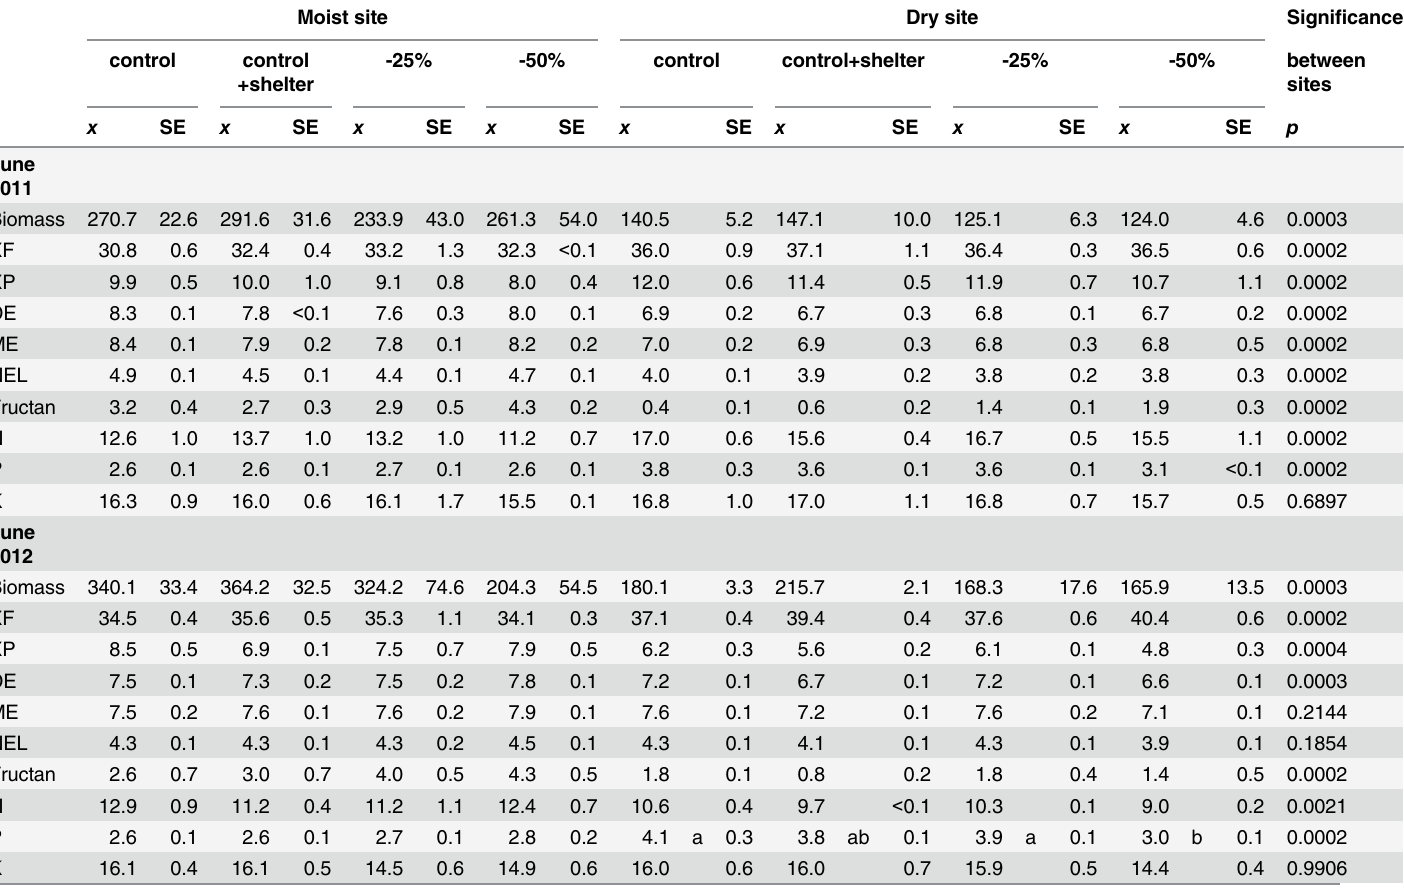
Table 2. Forage quality parameters of differently treated meadow plots (control, control +shelter), -25% precipitation, and -50% precipitation) on the moist and dry meadow site in the floodplain at the Rhine River. Moist